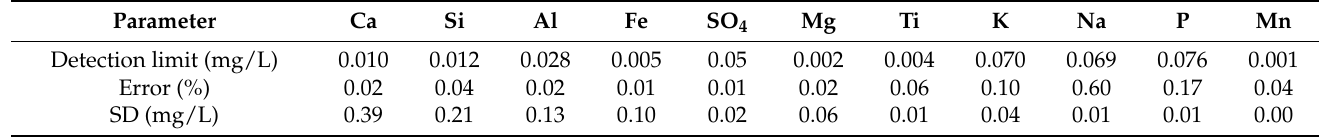
Table A2. Detection limit and error for each element and the standard deviation (SD) of the results on the reference cement. Parameter Ca Detection limit (mg/L)